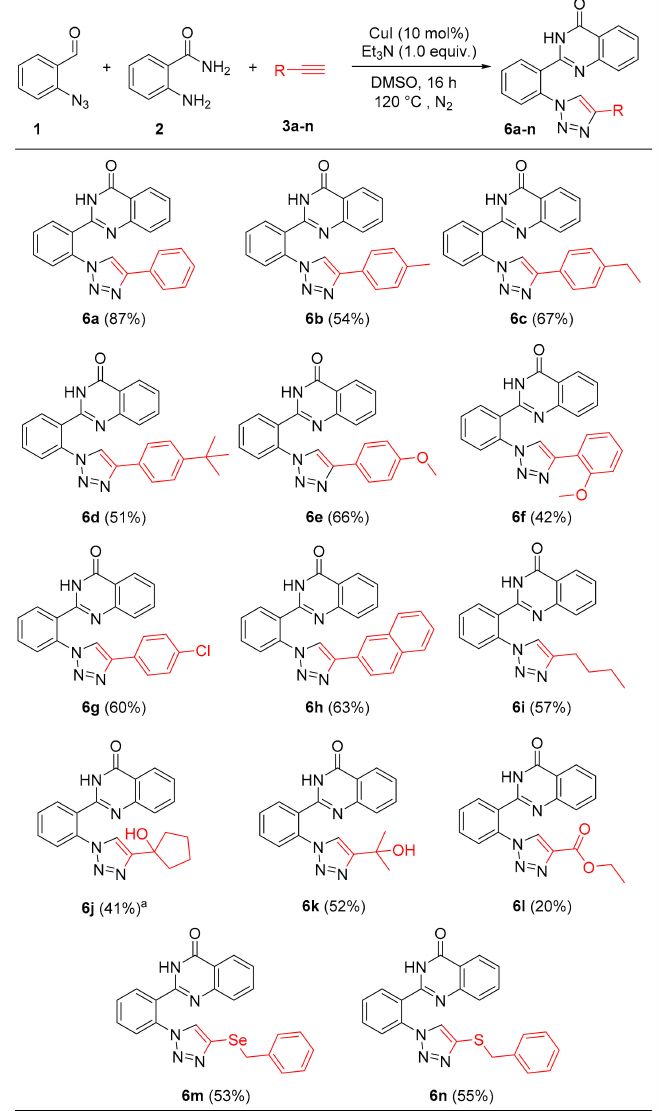
Figure 4. Reaction scope to obtain triazoylquinazolin-4(3H)-ones 6a-n . Reactions performed using 2-azidobenzaldehyde 1 (0.5 mmol), anthranylamide 2 (0.5 mmol), terminal alkynes 3a - n (0.5 mmol), CuI (10 mol%), and Et 3 N (0.5 mmol) in DMSO (1.5 mL) at 120 ◦ C under N 2 atmosphere for 16 h. Yields of isolated product after column chromatography. a Obtained as a mixture of 5j and 6j